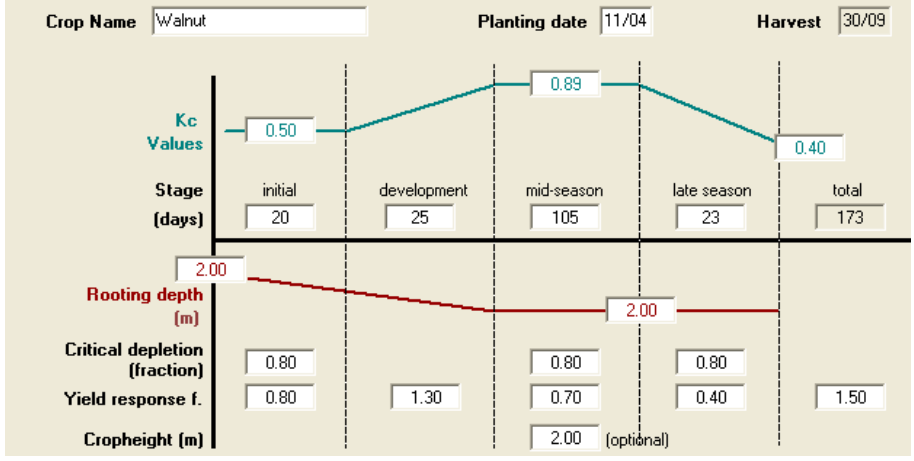
Figure 1. Çorum/Center crop k c values.